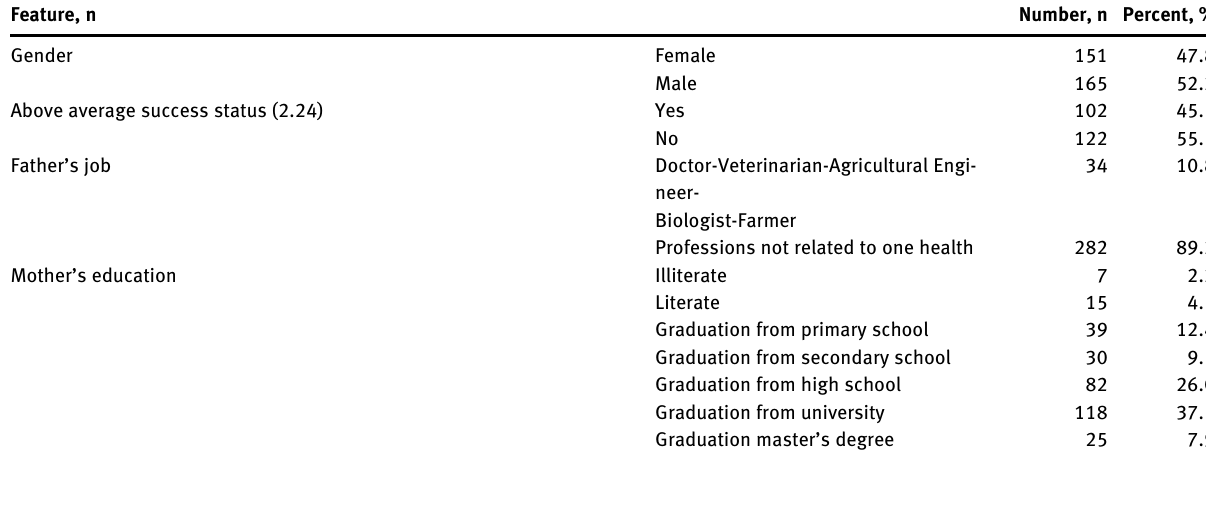
Table  : Descriptive characteristics of the participants in relation to socio-demographic variables, health status and habits. Feature, n Gender Above average success status (  . 